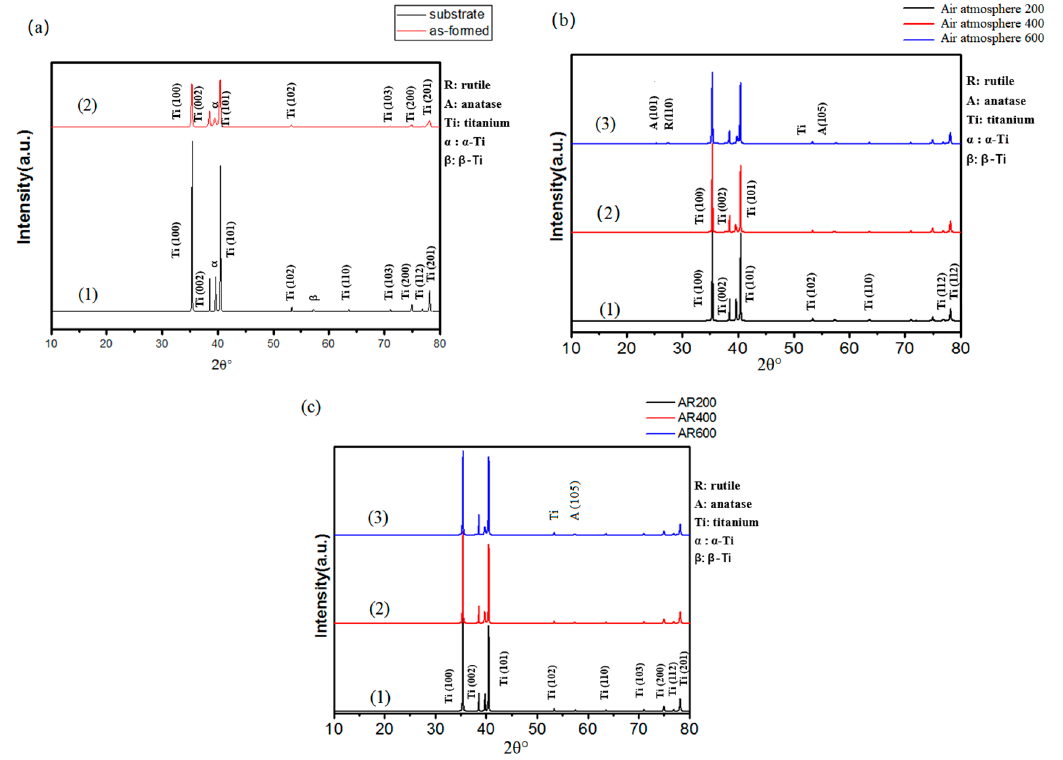
Figure 2. ( a ) X-ray diffraction (XRD) patterns of (1) substrate and (2) anodized sample; XRD patterns of the anodized samples with annealing ( b ) in air and ( c ) in Ar gas at (1) 200 °C, (2) 400 °C and (3) 600 °C.